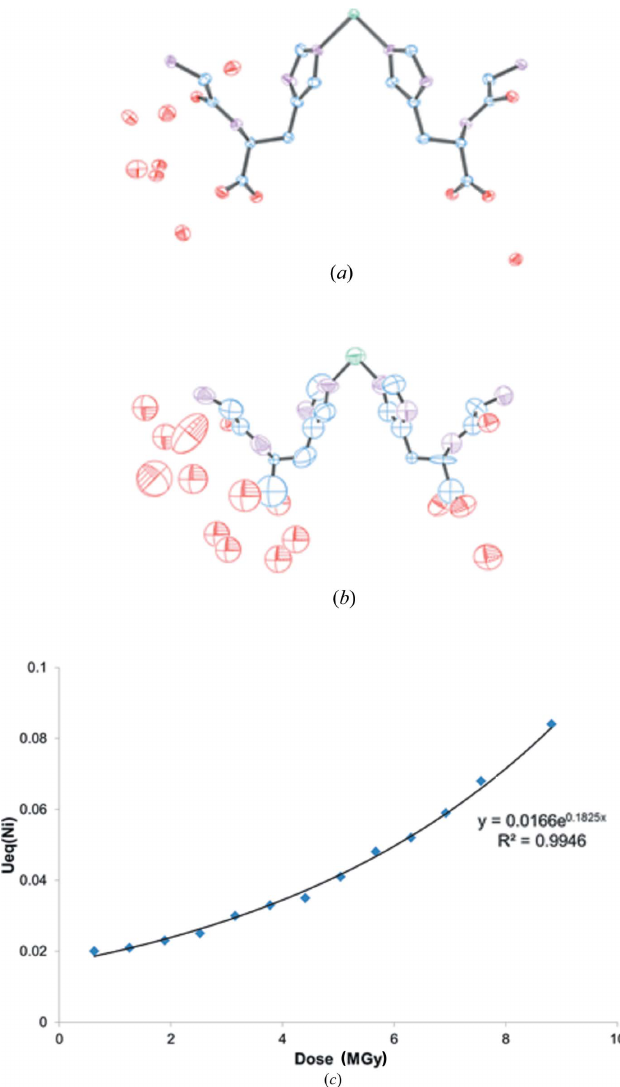
Figure 4 Thermal ellipsoid plots based on ( a ) the first i.e. 0.63 MGy and ( b ) the 14th i.e. 8.82 MGy scans. Carbon is shown in blue, nitrogen is shown in purple, oxygen is shown in red and nickel is shown in green. ( c ) The graph shows the development of U eq for the nickel site as a function of dose.